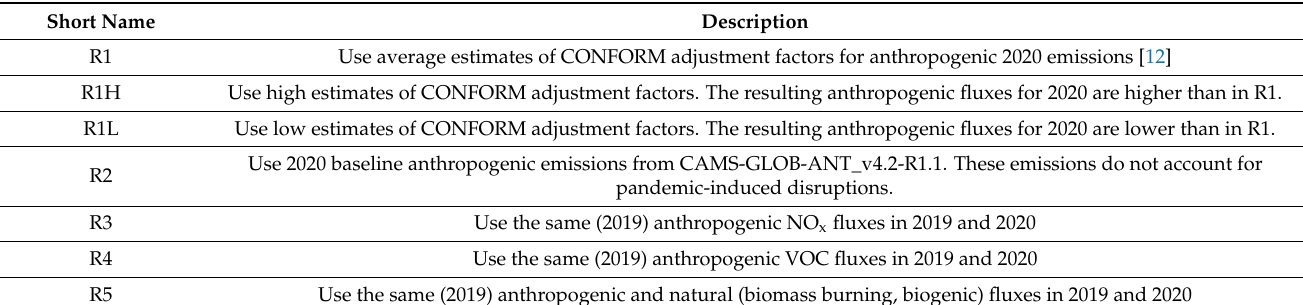
Table 1. Description of the model simulations. All simulations use the same emissions for 2019 but differ regarding their 2020 emissions.